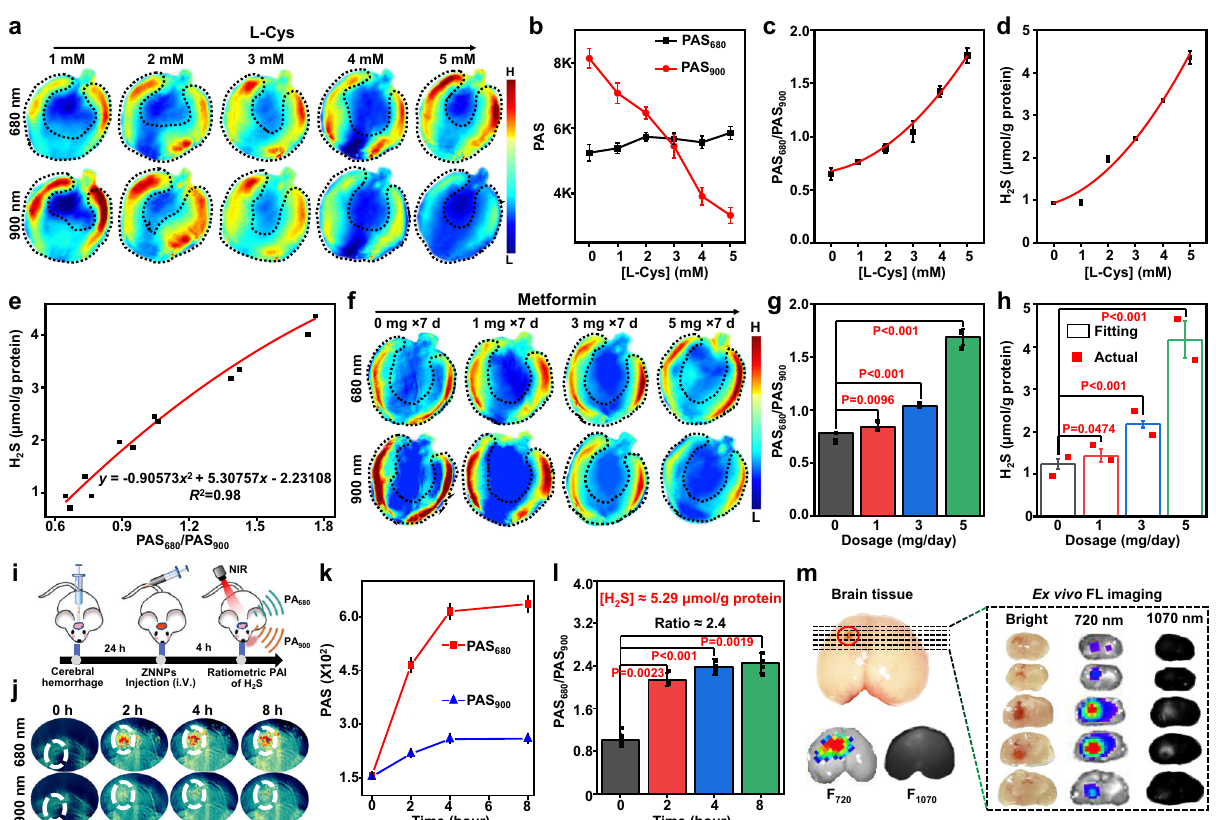
Fig. 5 Quantitative imaging of endogenous H 2 S in vivo. a PA images and b PA signals intensity of mouse livers at 680 and 900 nm, c Ratiometric PA signal PAS 680 /PAS 900 against various treatments (i.p.) of L-Cys (0, 1, 2, 3, 4, and 5 mM, 100 μ L) and i.v. injection of ZNNPs (10 mg/kg) after 30 min. Data are presented as mean ± s.d. ( n = 5 independent mice). d Actual H 2 S concentration in mouse liver in a . e Derived equation for endogenous H 2 S quanti fi cation. f PA images, g Ratiometric PAS 680 /PAS 900 signals and h H 2 S concentrations ( fi tting & actual) against various treatments (i.p.) of metformin (0, 1, 3, 5 mg in 100 μ L PBS buffer) for 7 days and i.v. injection of ZNNPs (10 mg/kg). Data are presented as mean ± s.d. ( n = 4 independent mice), data of “ Actual ” are presented as actual values ( n = 2 independent mice). i Schematic description of ICH model construction and detection of endogenous H j PA images, k PA intensity at 680 and 900 nm and l ratiometric PAS 680 /PAS 900 signals of ICR mice with i.v. injection of ZNNPs (10 mg/kg) ( n = 3). m Fluorescence images of mice brain slice in j . Statistical differences were analyzed by Student ’ s two-sided t-test. Source data are provided as a Source Data fi